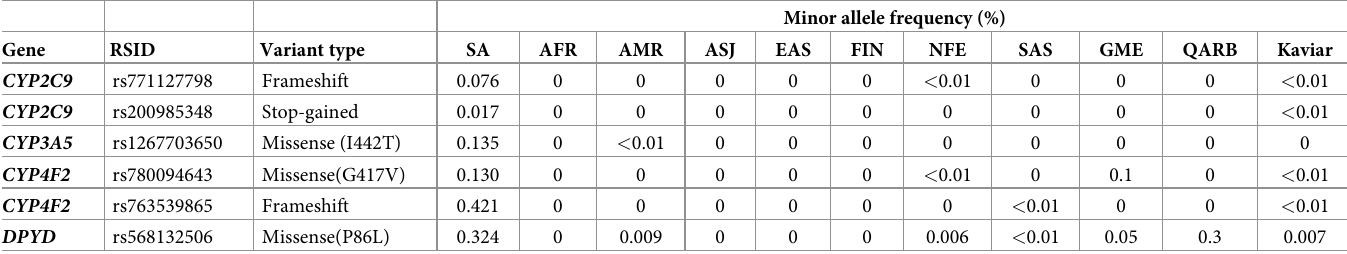
Table 2. Rare pharmacogenetic variants present in Saudi population in comparison to other